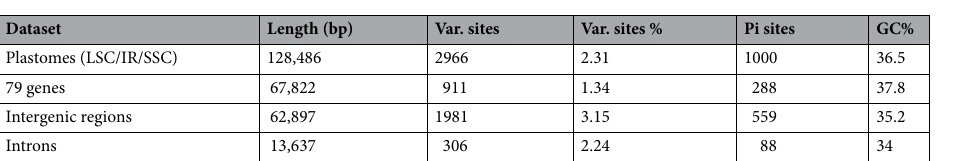
Table 3. Summary of datasets including only the 19 Mikania plastomes including length, number of variable sites (Var. sites), percentage of variable sites (Var. sites %), parsimony informative sites (Pi sites), and percentage of GC content